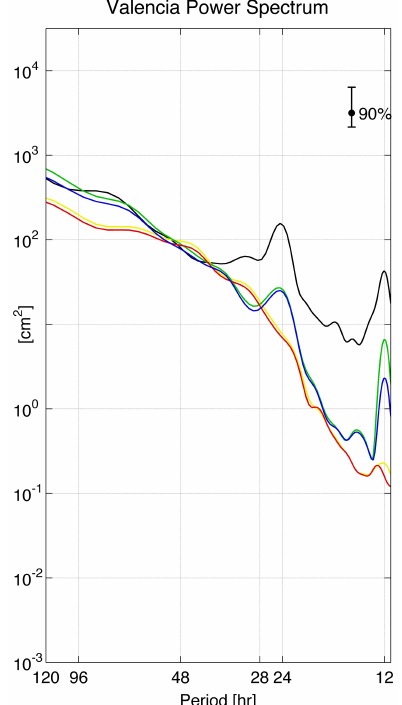
Figure 7. Valencia η power spectra from observations and mod- els results. Observations, black; NEMO-MFS1, red; NEMO-MFS2, blue; NEMO-MFS3, yellow; NEMO-MFS4,